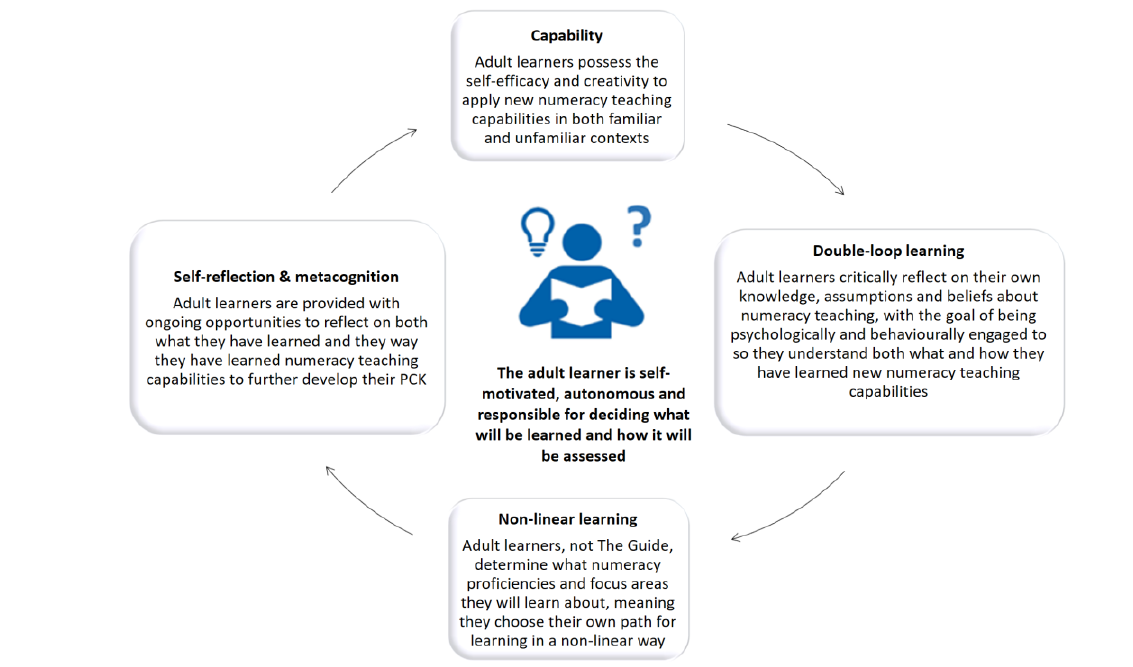
The Numeracy Guide’s Principles of